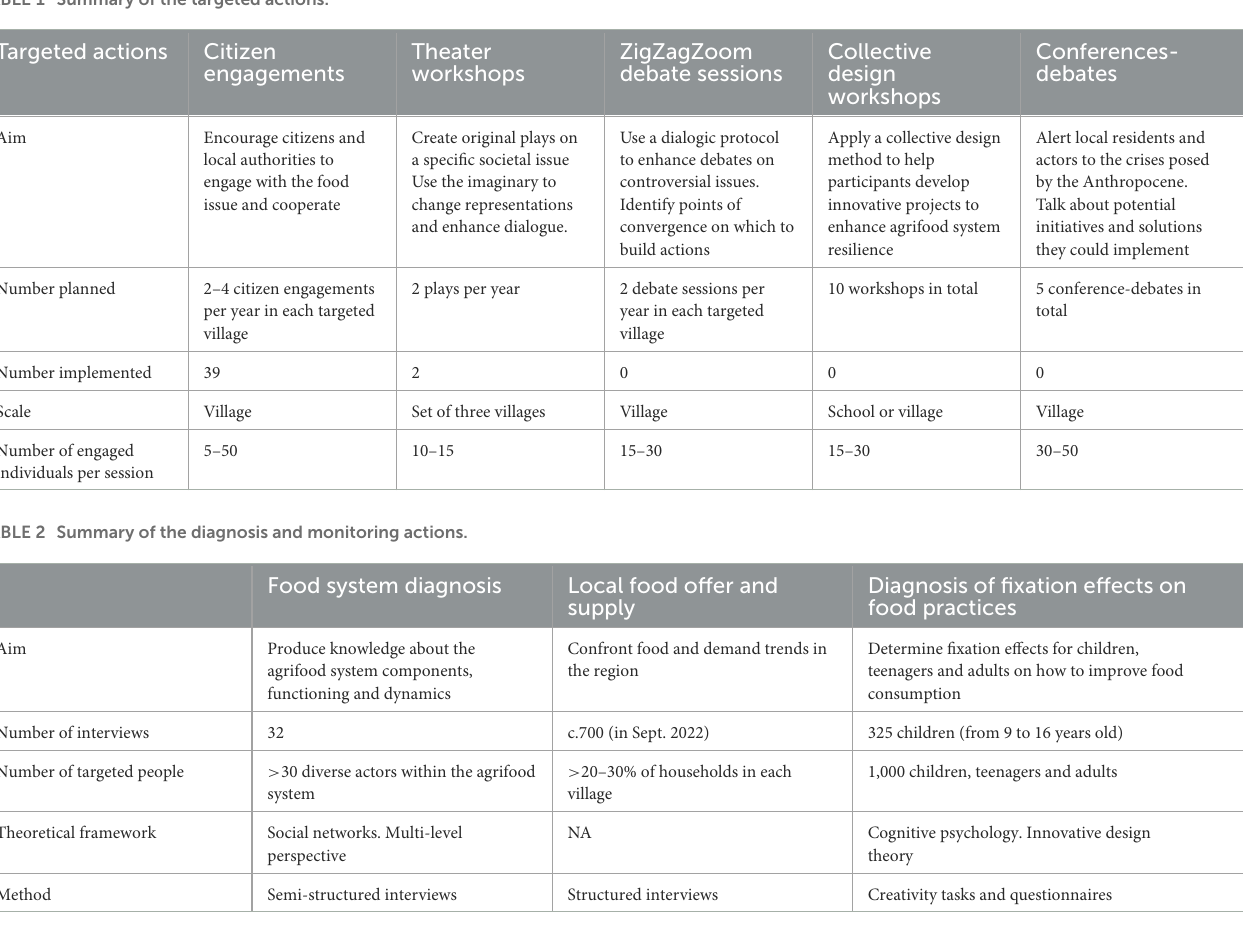
TABLE 1 Summary of the targeted actions.